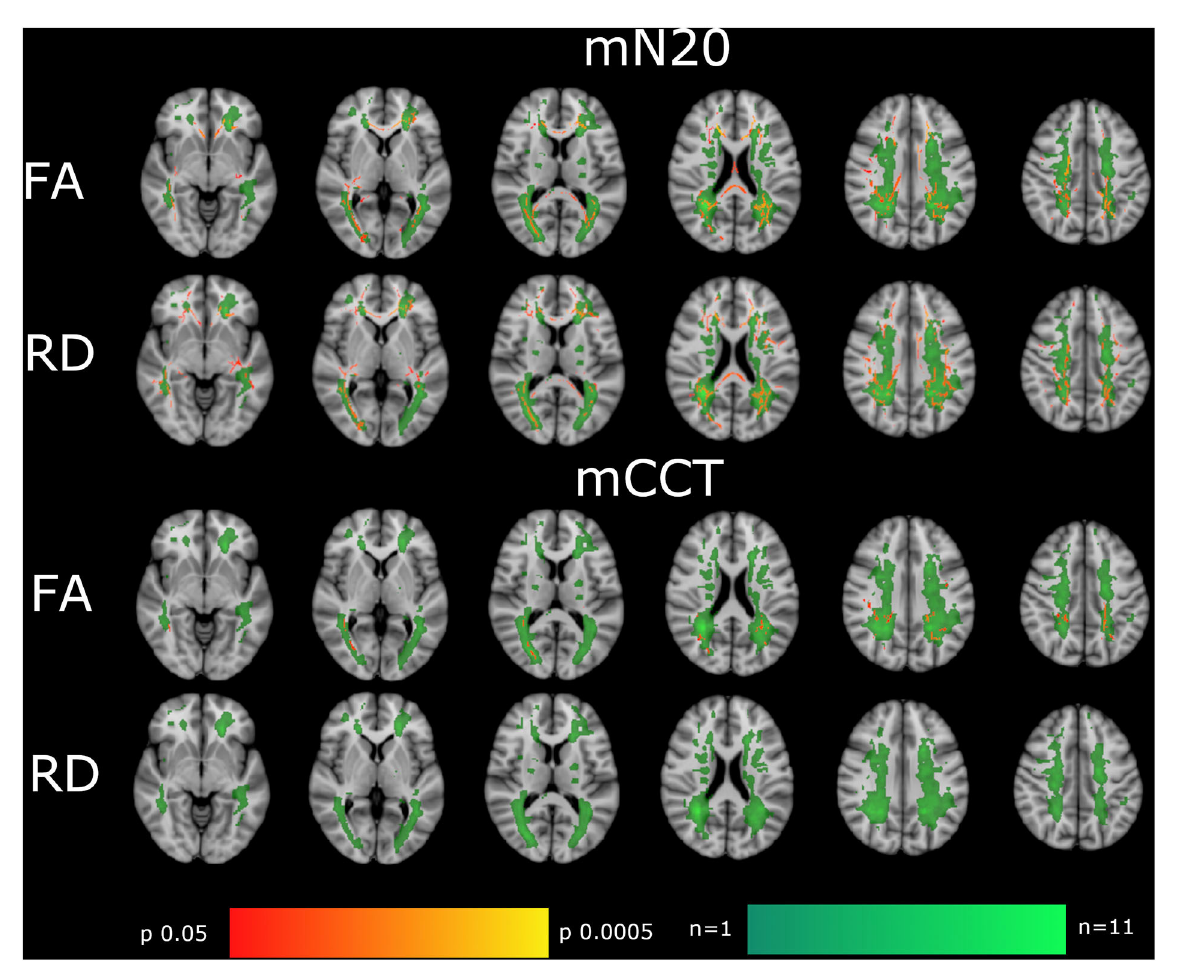
FIGURE2 Shown are the correlations of FA, RD with mN20, and mCCT of the tract-based spatial statistics results based on the GLM-model. Significant correlations are highlighted from red to yellow, from P = 0.0005 to P = 0.004. To visualize MS lesions the summarized lesions maps are presented in green. Dark green indicates regions where only 1 patient had a lesion, Whereas, light green indicates regions where 11 patients had lesions. The T1 Montreal Neurological Institute 158 brain is the background image. First row: correlation of FA with mN20. Second row: RD with mN20. Third row: FA with mCCT. Fourth row: RD with mCCT. Correlations are widespread in the brain with the highest correlation in the Corona radiata superior and posterior, the visual tract and corpus callosum. MS lesions are most frequently around the ventricles. Locations with the most lesions are